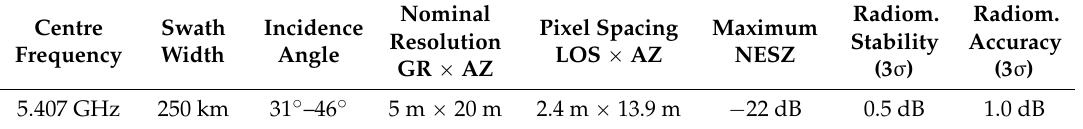
Table 1. Main characteristics of Sentinel-1 SAR data in Interferometric Wide swath (IW) mode [3]. Nominal spatial resolution for single look complex (SLC) data. GR: Ground range; AZ: azimuth. LOS: line-of sight. NESZ: noise equivalent